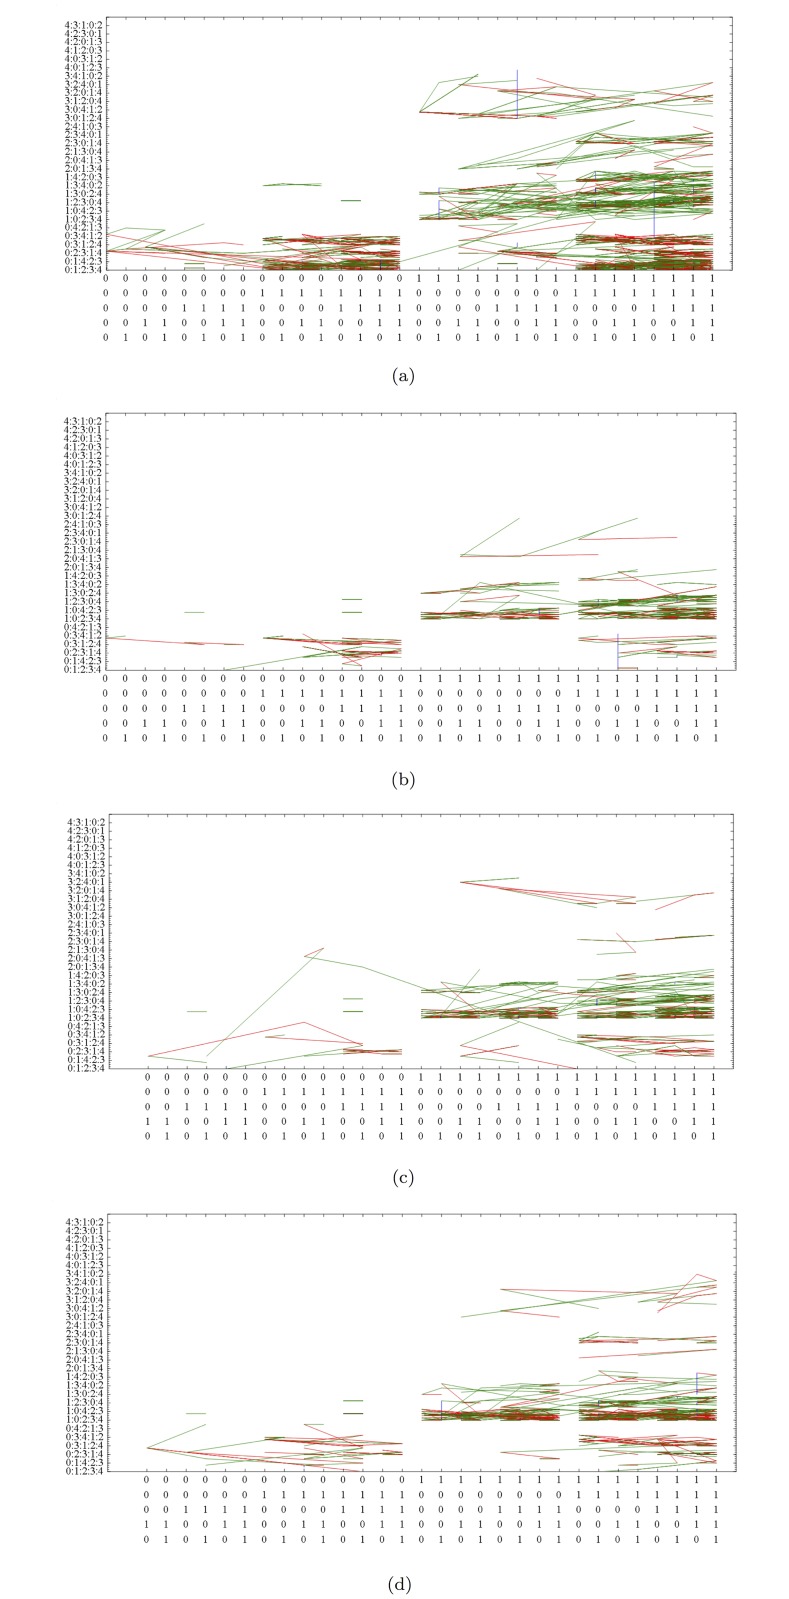
Orbits of (a) SA Rich, (b) SA Poor, (c) MOZ Rich, and (d) MOZ Poor households.Observe clusters formed in regions of each subpopulation. variable 4 (influx) is most frequently changing in all four subpopulations so orbits do not stay in the region where y = 4****. Not all 5! significance states are shown.